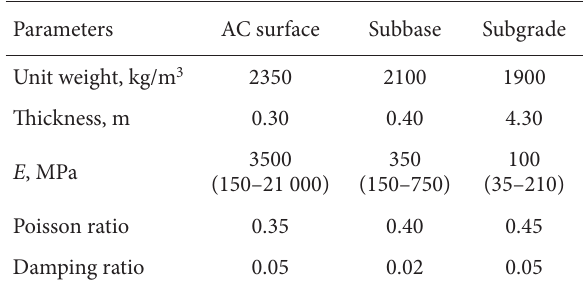
Table 1. Modeling parameters for pavement systems